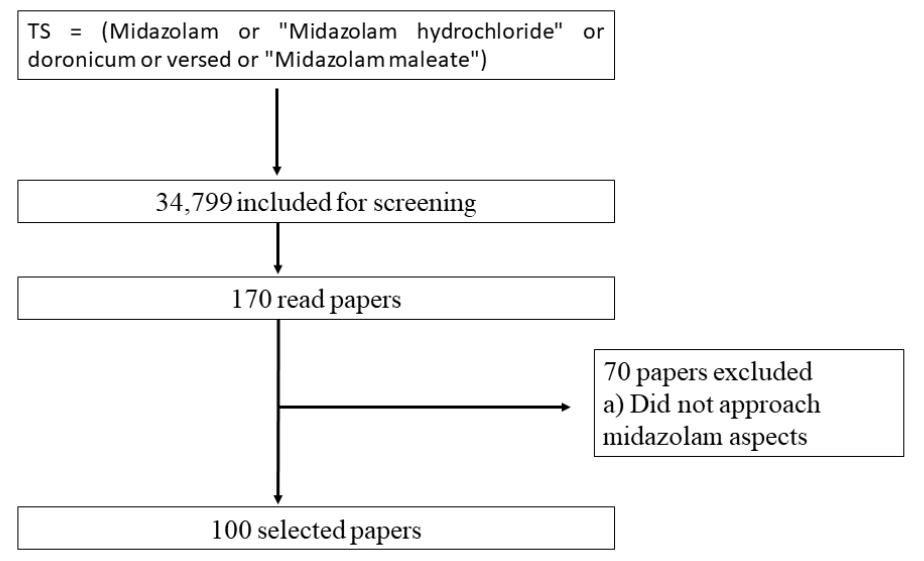
Figure 1. Flowchart of the literature and article screening.